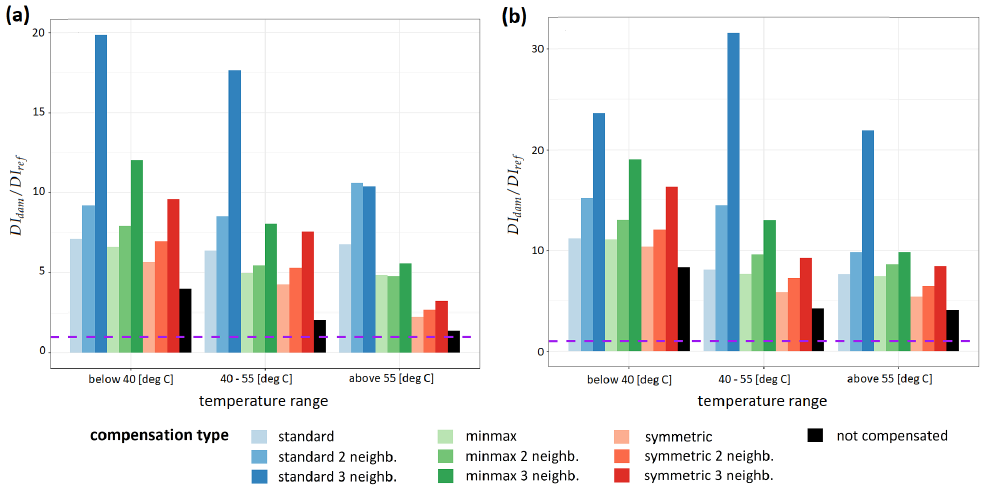
Figure 10. Comparison of damage detection efficiency for different schemes of damage indices compensation at different temperature levels for specimen no. 1: ( a ) for corr damage index; ( b ) for divAmp damage index.